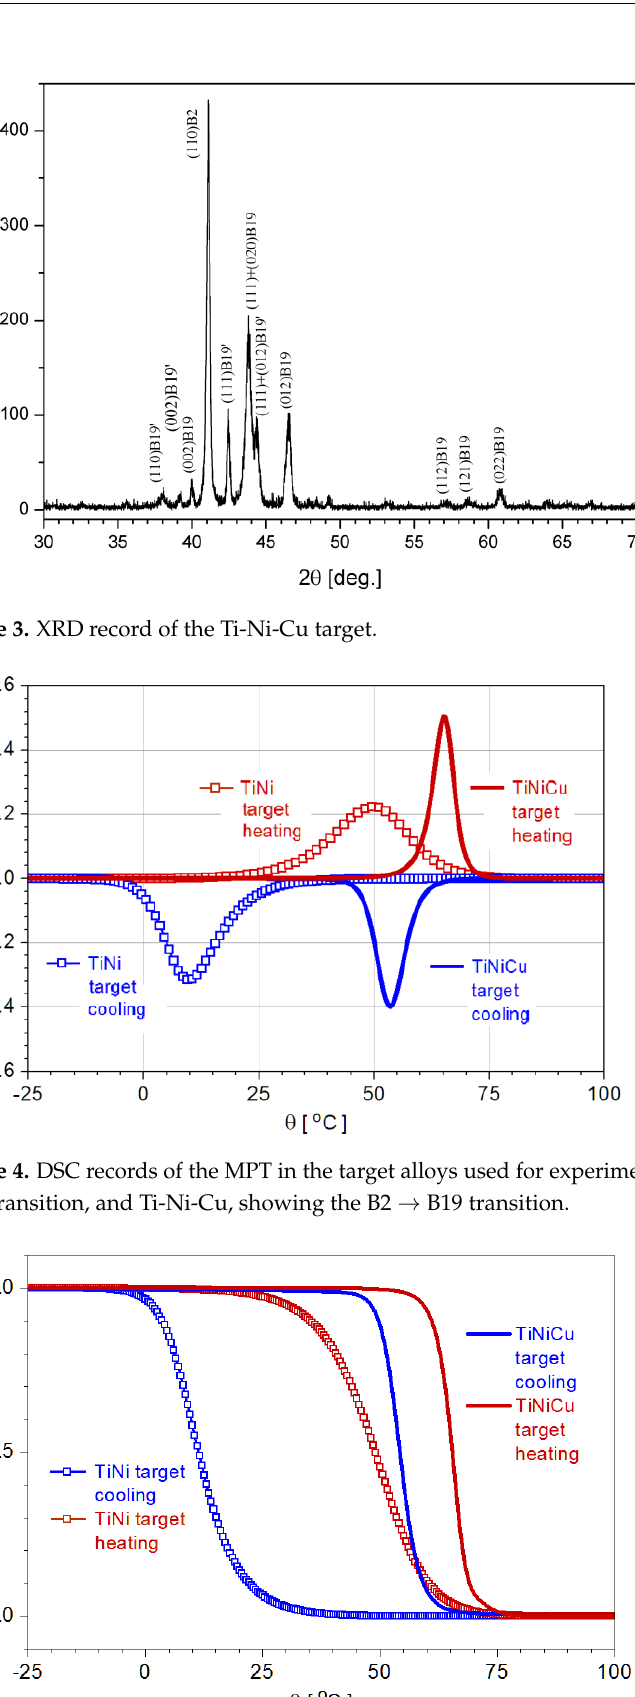
Figure 5. The thermal evolution of the martensite volume fraction for the target alloys.